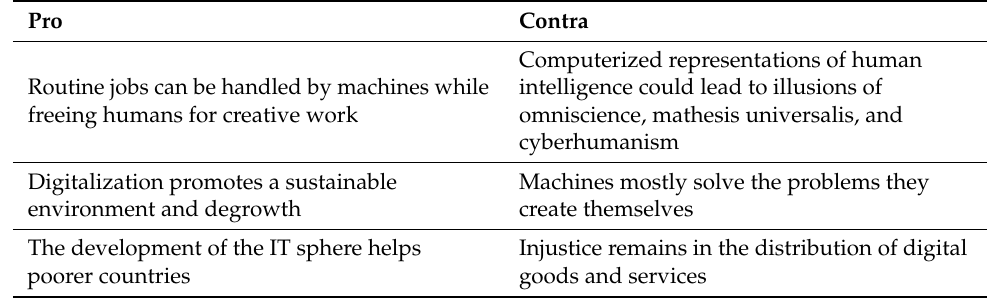
Table 1. Digitalization as